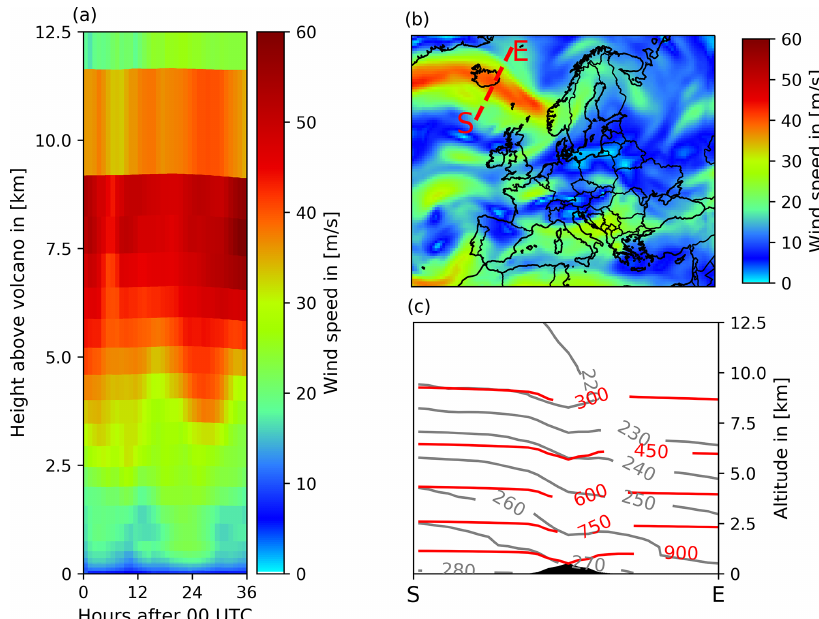
Figure 4. Meteorological conditions on 15 April 2010. (a) Wind speed above the volcano for the whole simulation period. (b) Wind speed at 500hPa on 15 April 2010, 12:00UTC, which corresponds to approx. 5km above the volcano. (c) Vertical cross section of isobars in [hPa] (red) and isotherms in [K] (gray) along the red line in (b) on 15 April 2010, 12:00UTC.